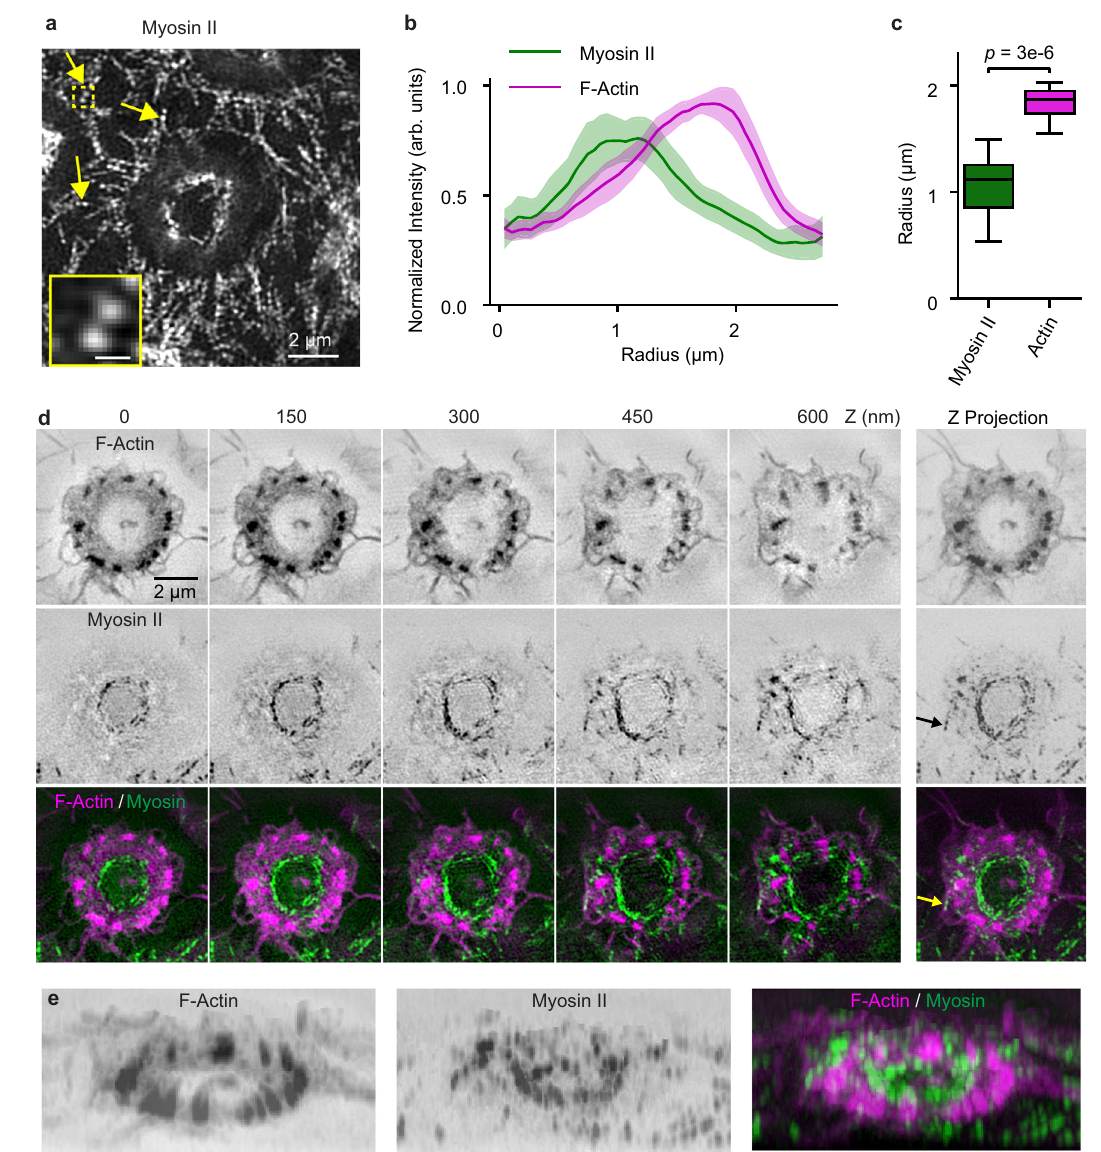
Fig. 8 | Myosin II fi laments in macrophage frustrated phagocytosis. a Macrophages plated on micropatterned IgG-Alexa 647 disks, with myosin II markedusingRLC-EGFPandimagedwithTIRF-SIM.MyosinII fi lamentsformeda small ring within the circle of podosomes during macrophage frustrated pha- gocytosis. Individual myosin II bipolar fi laments were visualized as doublets (arrows). The insert, showing a doublet, is a zoom of the dashed box. The scale bar of the insert is 300nm. b Radial distributions of actin and myosin II